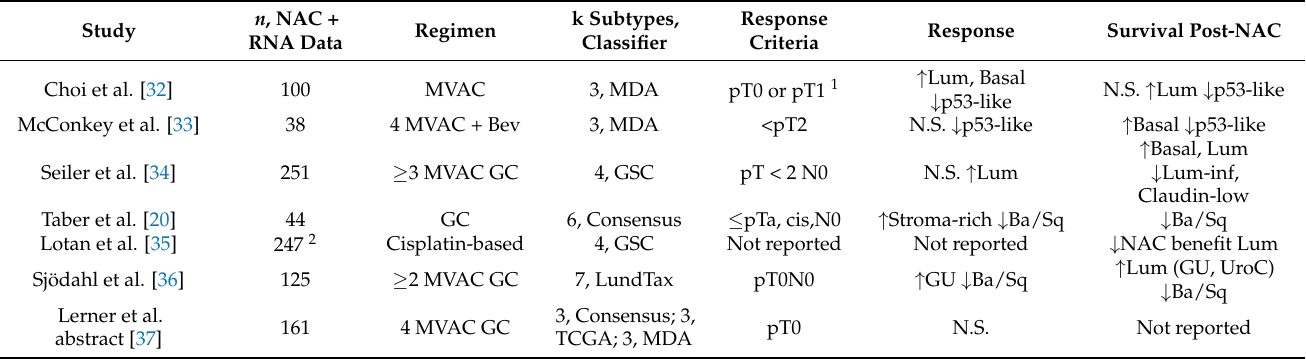
Table 1. Studies on NAC response with original RNA subtyping